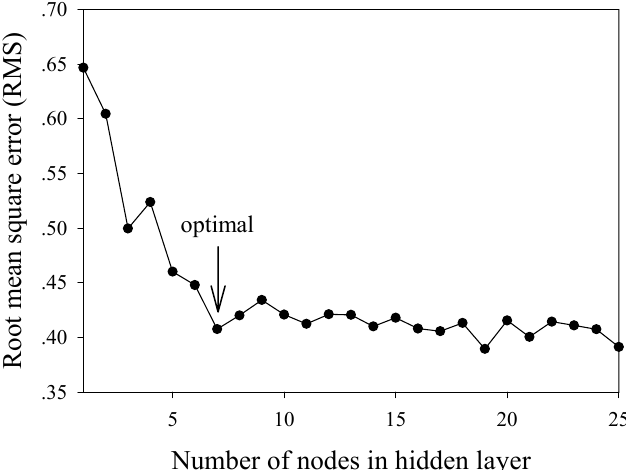
Figure 2. Plot of RMS as a function of the number of nodes in hidden